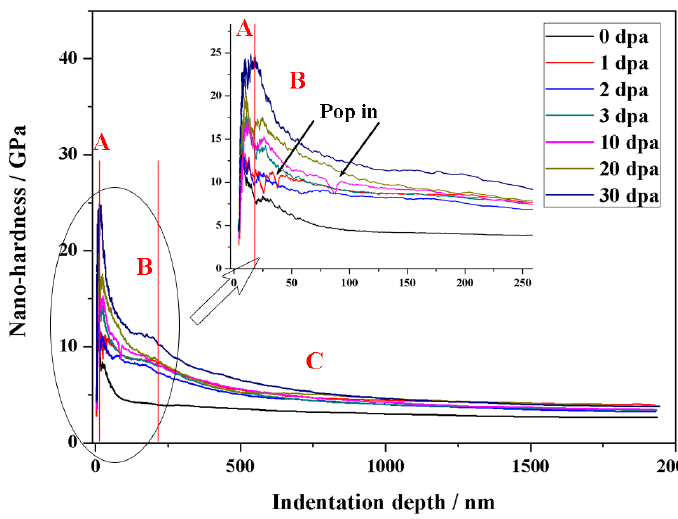
Figure 4. Depth profiles of nano-hardness of SA508-IV after different ion-irradiation doses. According to the Nix and Gao equation [22] for the ISE stage, which describes the relationship between nano-hardness ( H ) and depth ( h ),